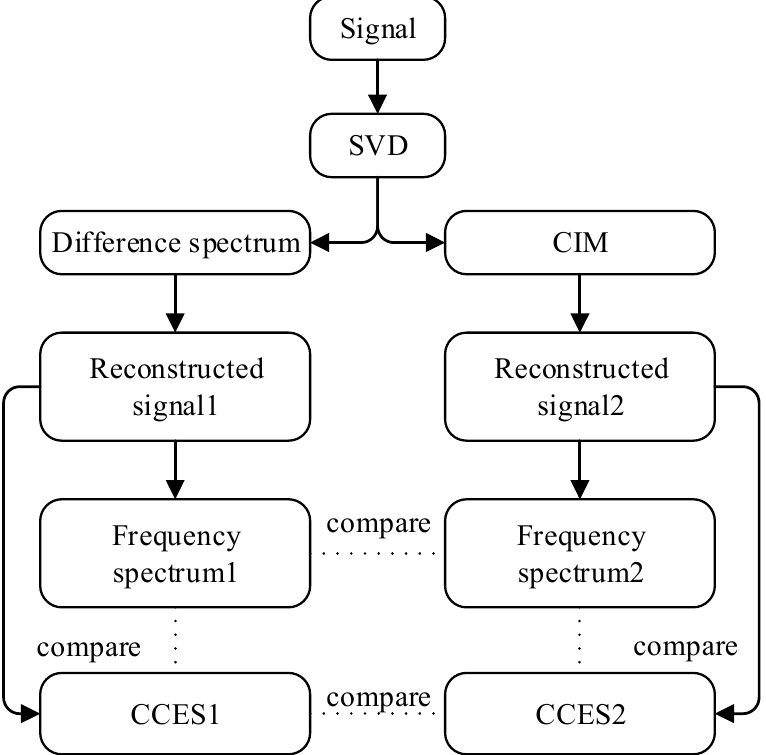
Figure 9. Single-channel method analysis flowchart.